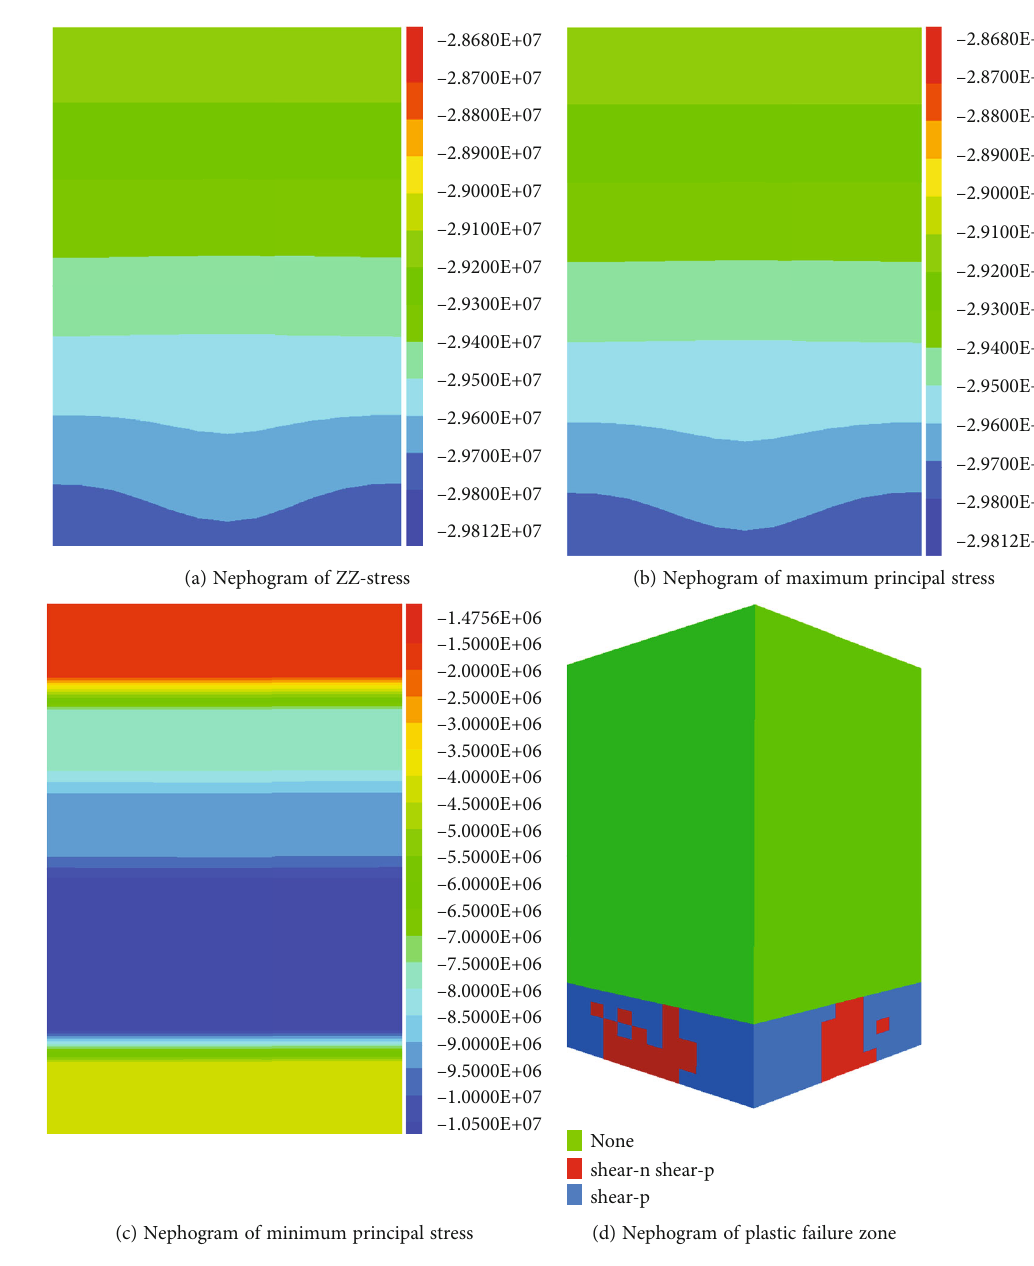
Figure 5: Nephogram of ground stress